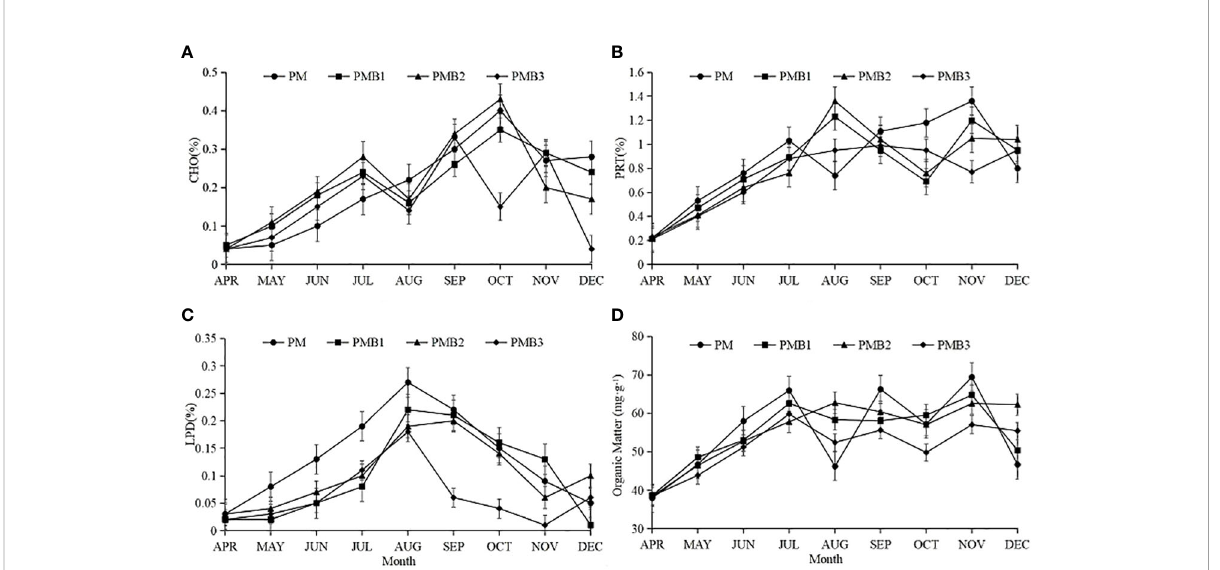
FIGURE 1 Changes in sediment easily degradable organics during the farming period. The data are shown as the means±SDs. (A) , change of CHO; (B) , change of PRT; (C) , change of LPD; (D) , change of Orgnic matters. CHO, carbohydrate in the sediment; PRT, protein in the sediment; LPD, lipid in the